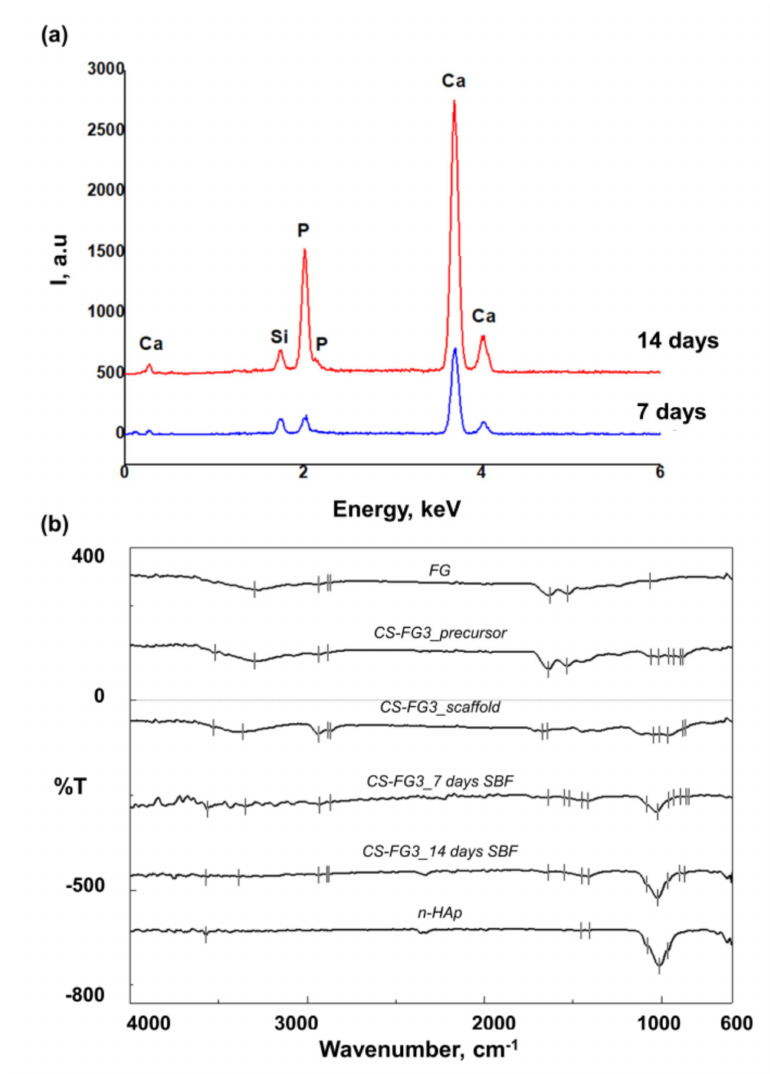
Figure 5. Representative structural information after the incubation of the samples in SBF: ( a ) EDX spectra; ( b ) FTIR–attenuated total reflectance (ATR) spectra recorded for the CS–FG3 sca ff old before and after incubation for 7 and 14 days in SBF, compared to FG, the injectable precursor, and the control hydroxyapatite